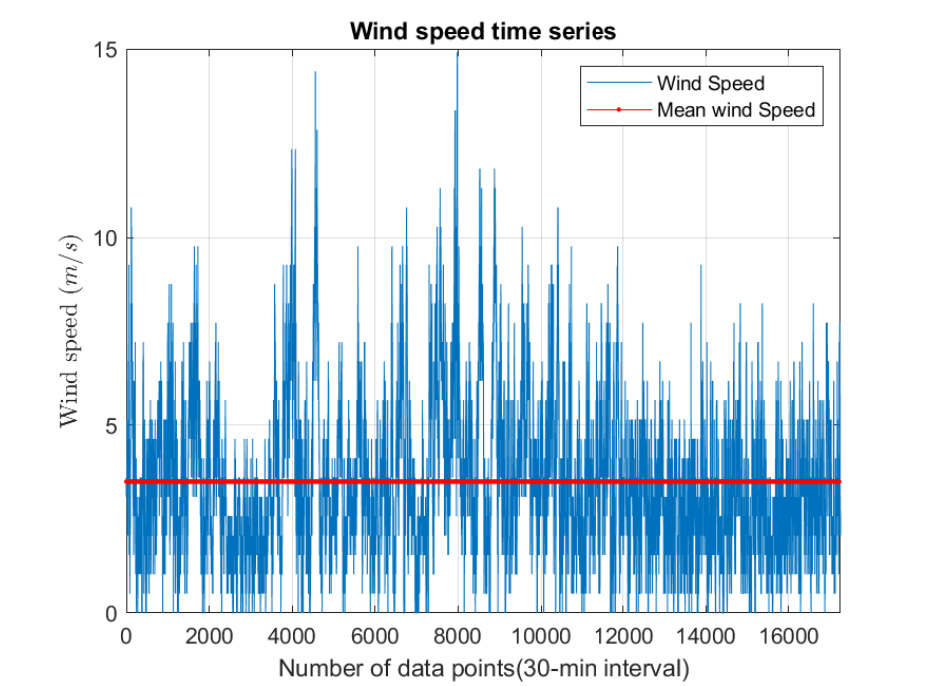
Figure 11. The portraits of wind speed time series and mean speed ( ¯ v = 3.4934 m/s) in OSWFs in Yangshan port, Shanghai from 22 August 2017 to 22 August 2018.